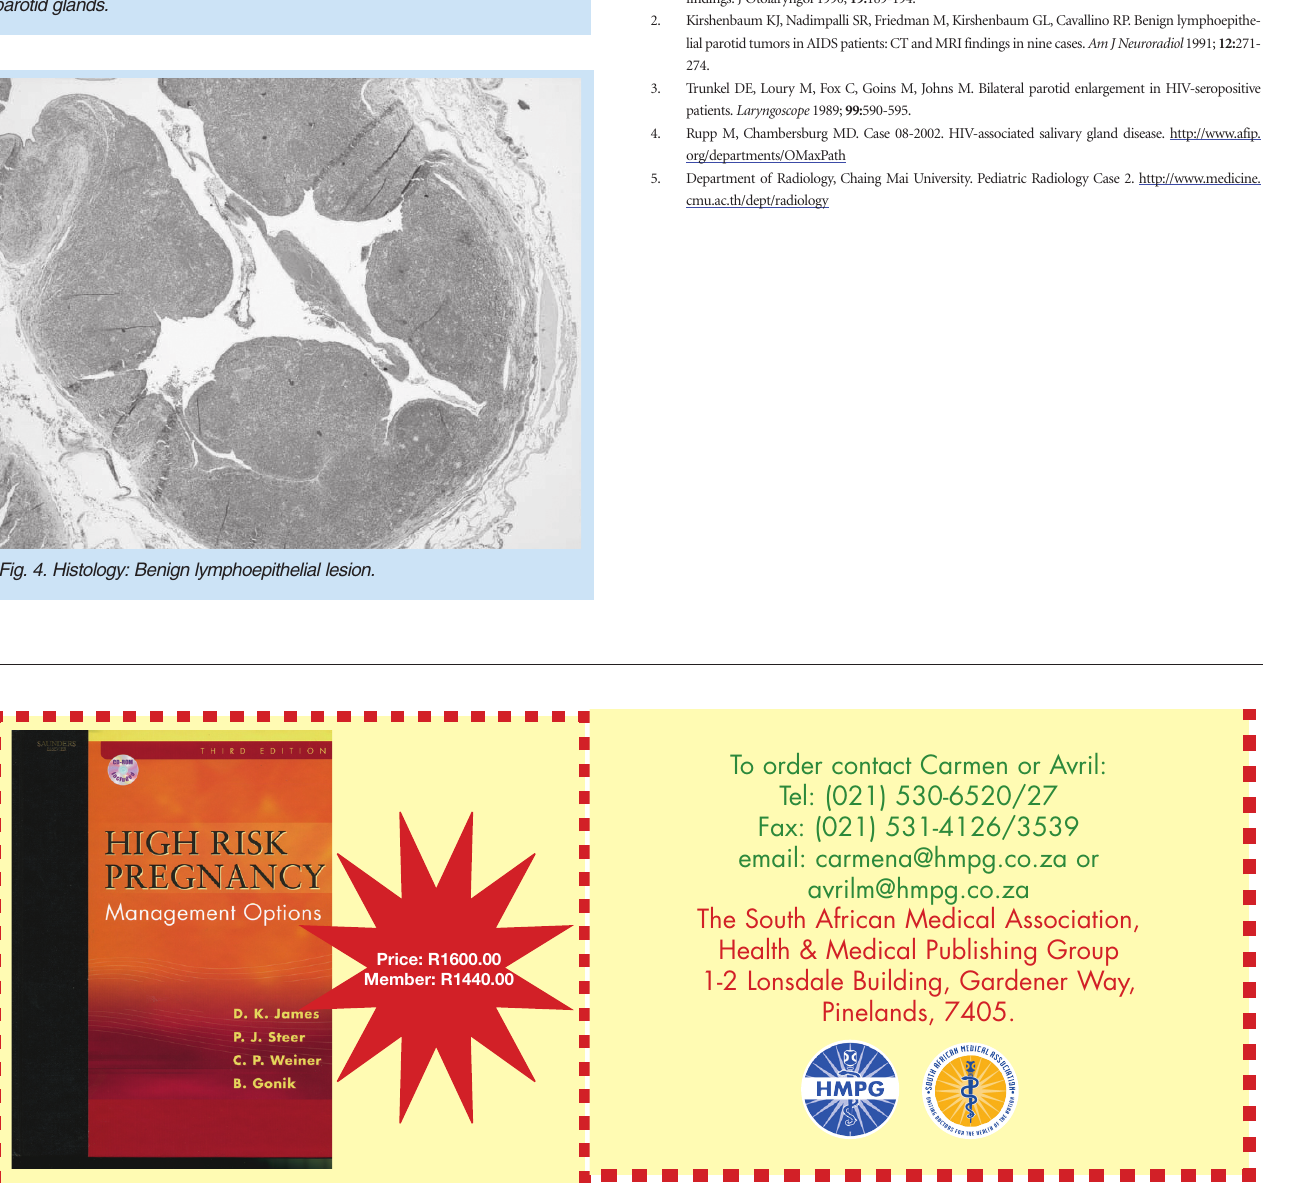
Fig. 3. MRI (T2-weighted image): Multiple variable sized cysts in both parotid glands.